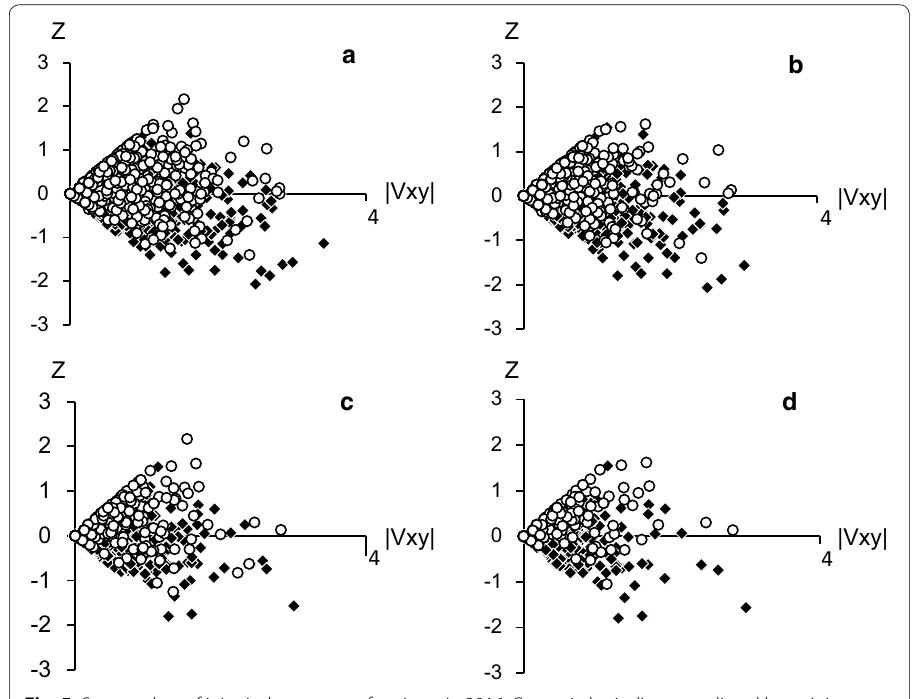
Fig. 5 Scatter plots of joint index vectors of patients in 2016. Open circles indicate predicted large-joint- dominant patients and solid squares represent the other groups. Target patients were a all patients, b methotrexate users, c biological disease-modifying anti-rheumatic drug users, and d both methotrexate and biological disease-modifying anti-rheumatic drug